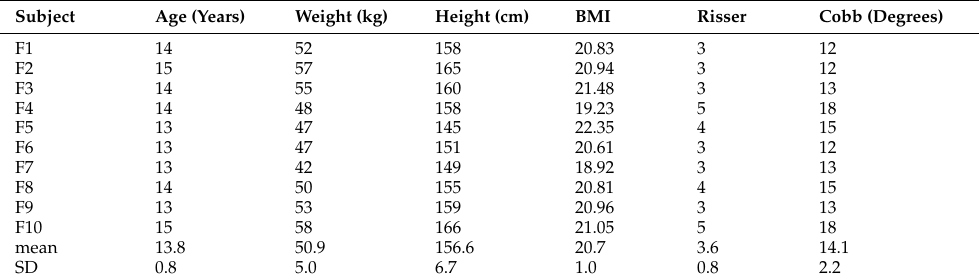
Table 1. Anthropometric characteristic of the convenient sample of